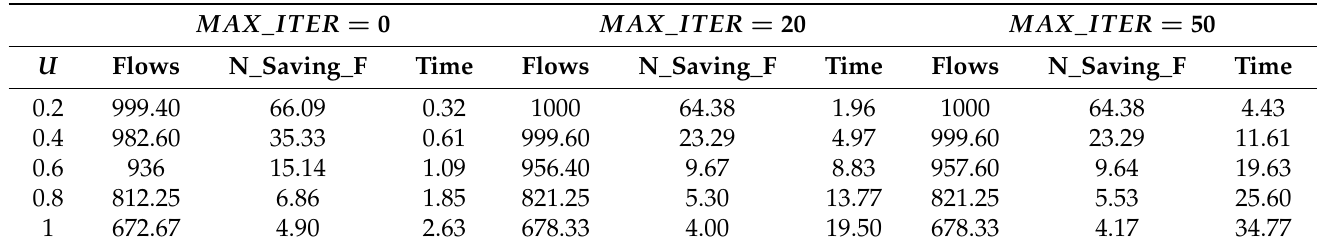
Table 6. 12eight servers-1000 flows-Flow scheduling with Simple heuristic in phase 2.